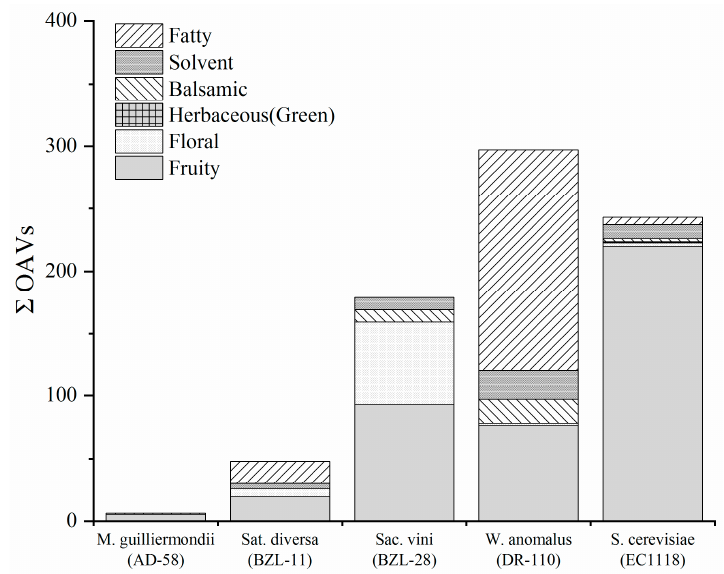
Figure 3. Sum of OAVs of different aroma series in five fermented media.